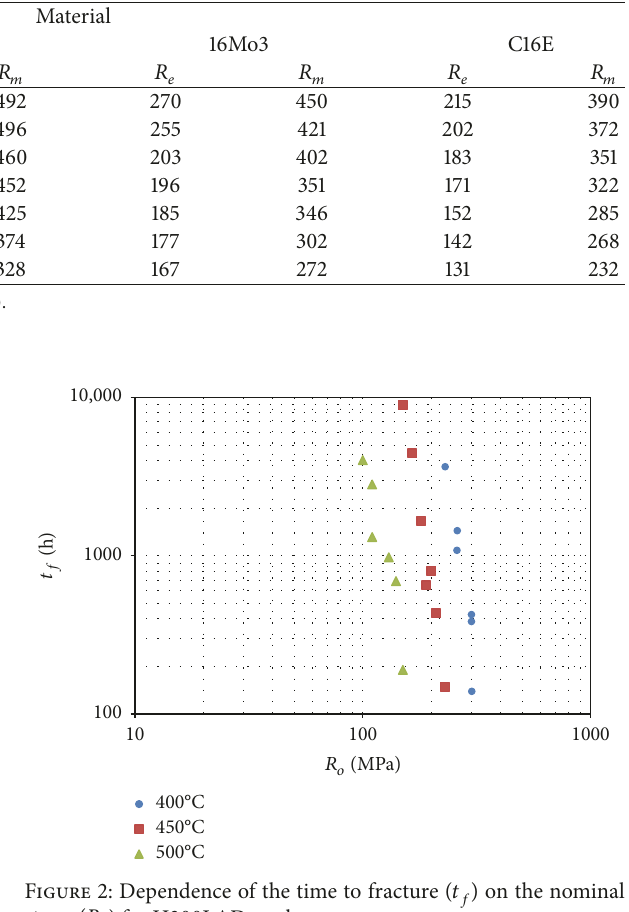
Table 2: Tensile testing under static conditions at elevated temperatures.